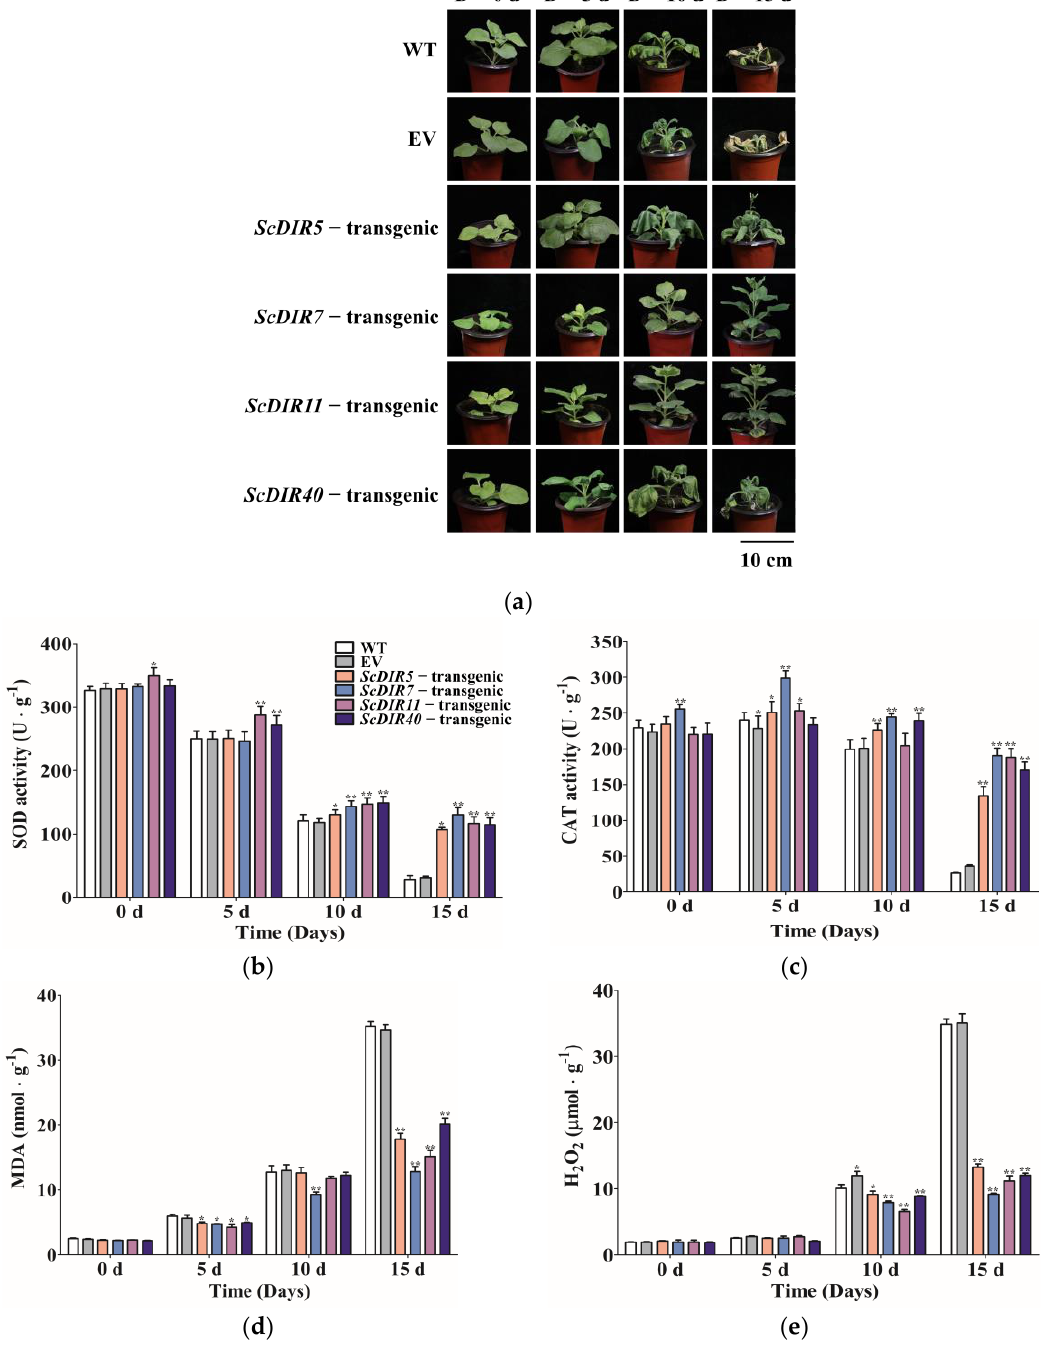
Figure 7. Phenotypes and physiological indices of ScDIR transgenic lines after drought stress. ( a ), Drought tolerance of transgenic tobacco plants overexpressing ScDIR genes. Photographs were taken before and after drought treatment. ( b – e ), Indexes of SOD, CAT, MDA, and H 2 O 2 in WT and ScDIR transgenic lines. Error bars denote the standard deviation calculated from three independent experiments. Significant differences were determined by t − test. * p < 0.05, ** p <